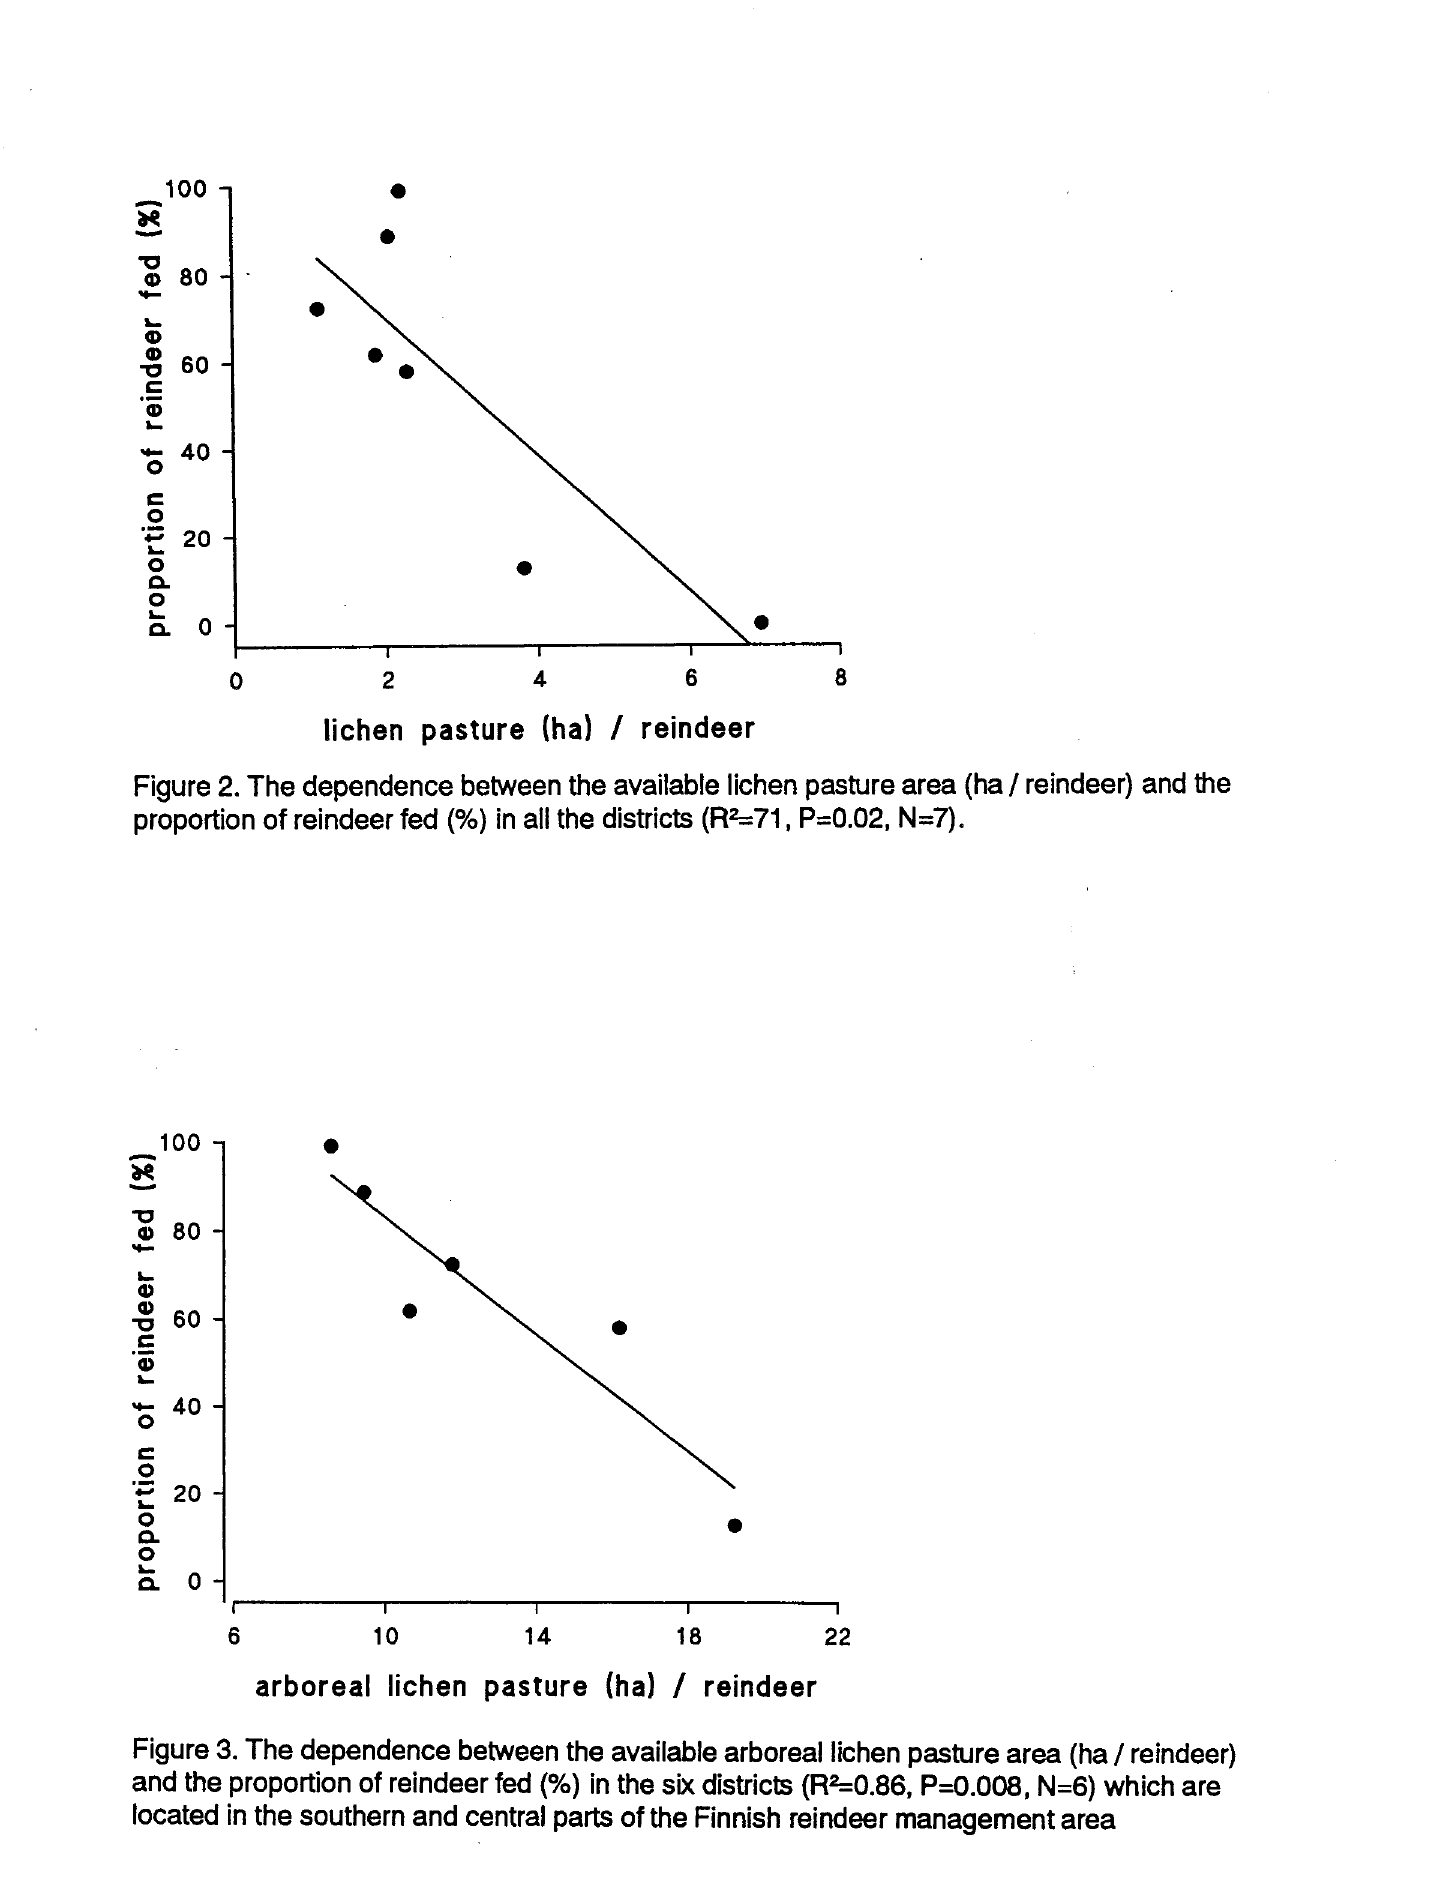
Figure 3. The dependence between the available arboreal lichen pasture area (ha / reindeer) and the proportion of reindeer fed (%) in the six districts (R^O.86, P=0.008, N=6) which are located in the southern and central parts of the Finnish reindeer management